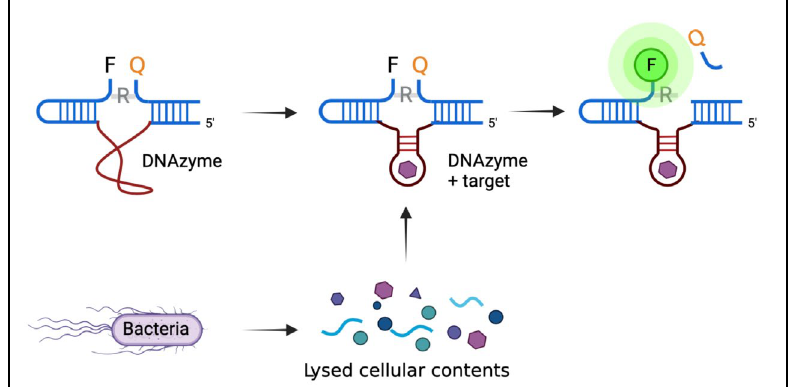
Figure 2. Representation of RFD-based sensor. The targets produced by the bacterium bind to the inactive DNAzyme sequence, which undergoes a conformational change to activate the DNAzyme. Then, activated DNAzyme catalyzes the cleavage of the fluorogenic substrate at the ribonucleotide junction (R), leading to the separation of the fluorophore (F) and the quencher (Q) to produce a fluorescence